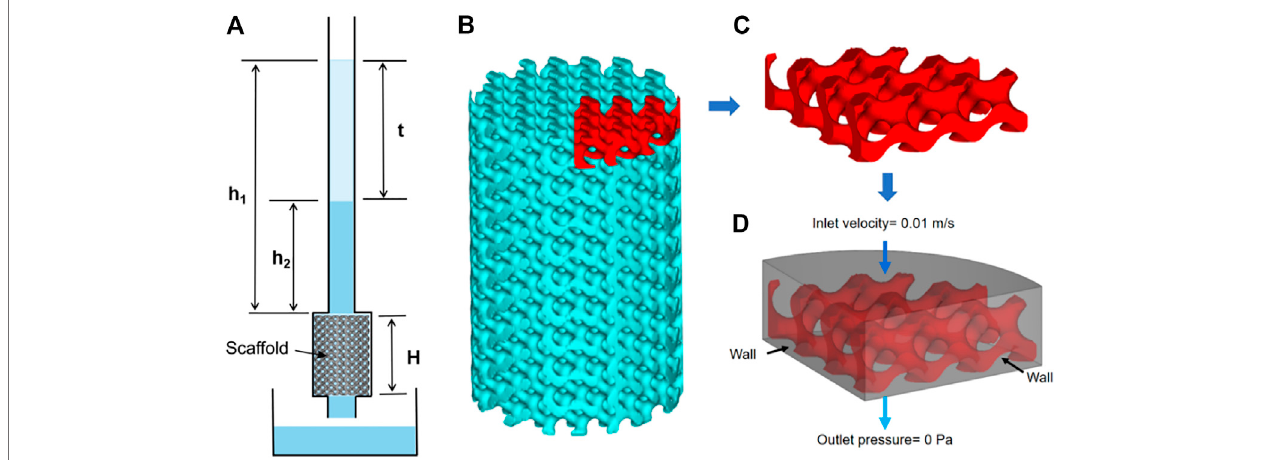
FIGURE 2 | Permeability experiments and fi nite element simulations: (A) schematic representation of the experimental device used in the falling head permeability test, (B) scaffold model, (C) model for fi nite element simulation, and (D) boundary setting for fi nite element simulation.